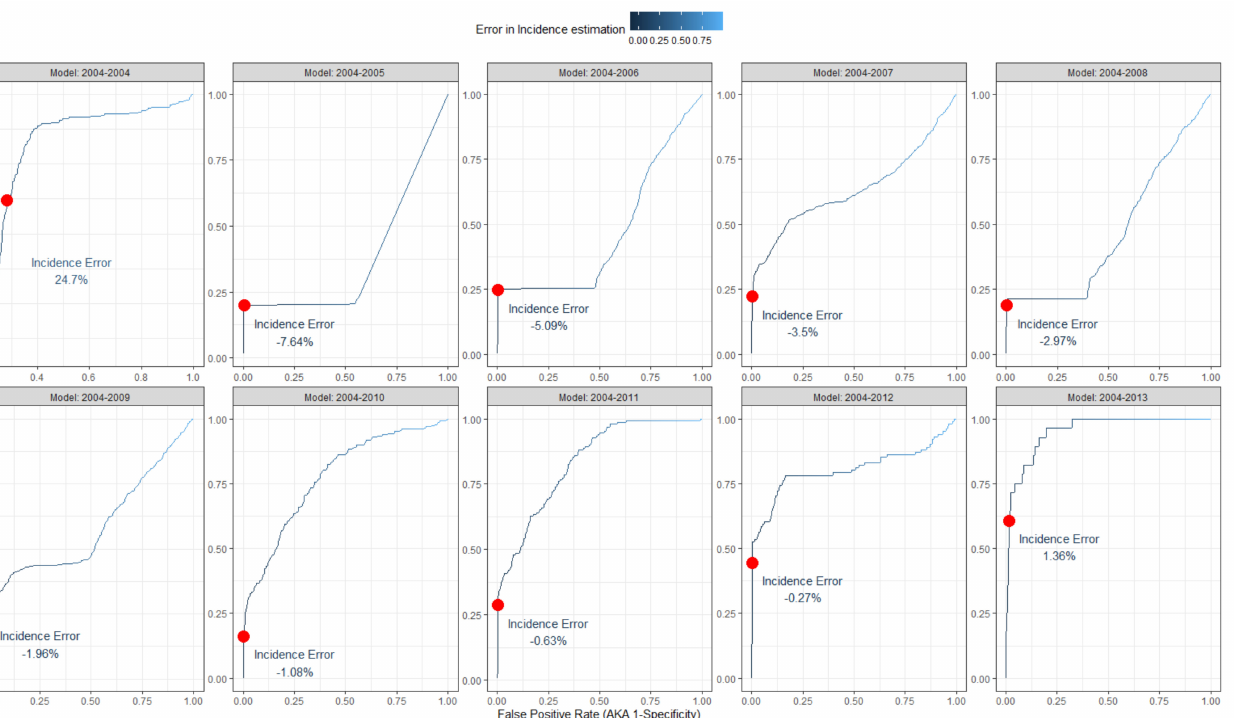
Estimated Estimated Observed Incidence Incidence Incidence Error (%) (%) (%)